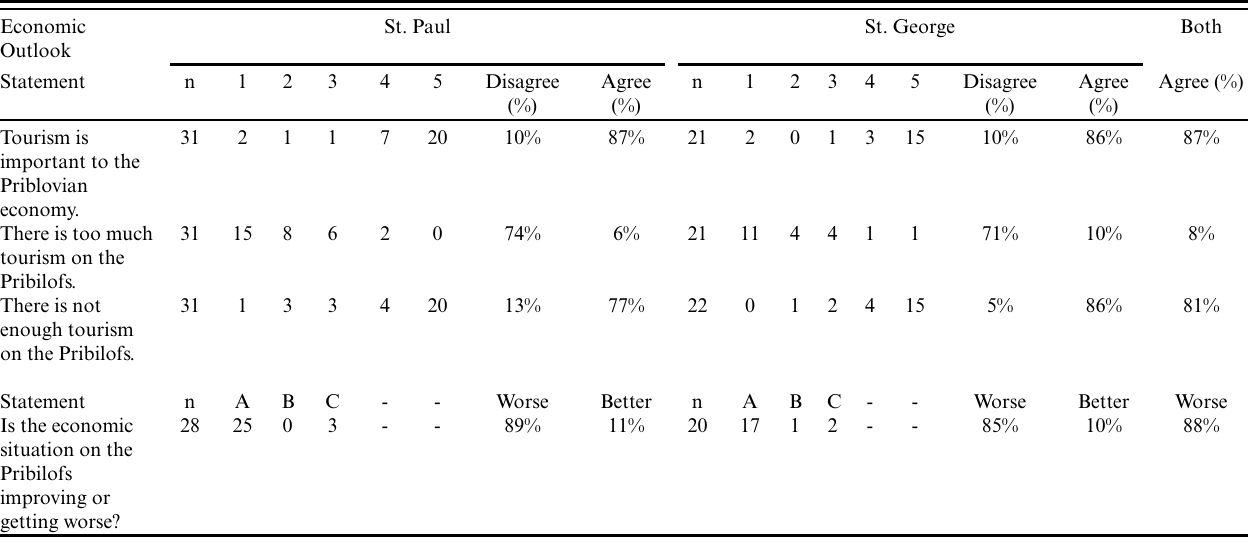
Table 5 . Survey responses to statements assessing perceptions of economic conditions and tourism. For each island the sample size (n) responding to each question is given, along with the responses broken down according to the Likert scale: 1 = Disagree; 2 = Somewhat Disagree; 3 = Neither; 4 = Somewhat Agree; and 5 = Agree. The last statement was not done on the Likert agreement scale: A = worse; B = stable; and C = improving. For each statement the percent of responses agreeing and disagreeing (or claiming worse vs. improving) is provided for each community. The last column indicates the percentage of responses in agreement with the statement in the entire sample. For the last statement, it indicates those who felt the economy was getting